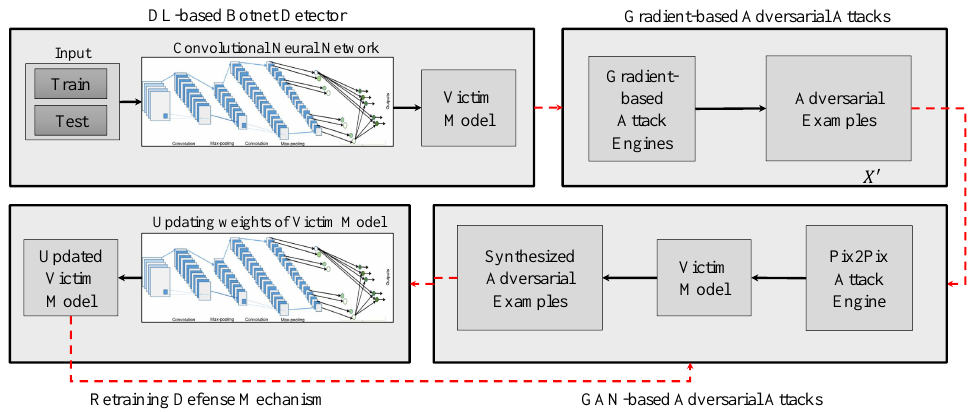
Figure 1. General structure of our proposed attack and defense system. It is composed of four main components, including DL -based botnet detector, Gradient-based adversarial attacks, GAN -based Adversarial attacks, and defense mechanism based on retraining of victim